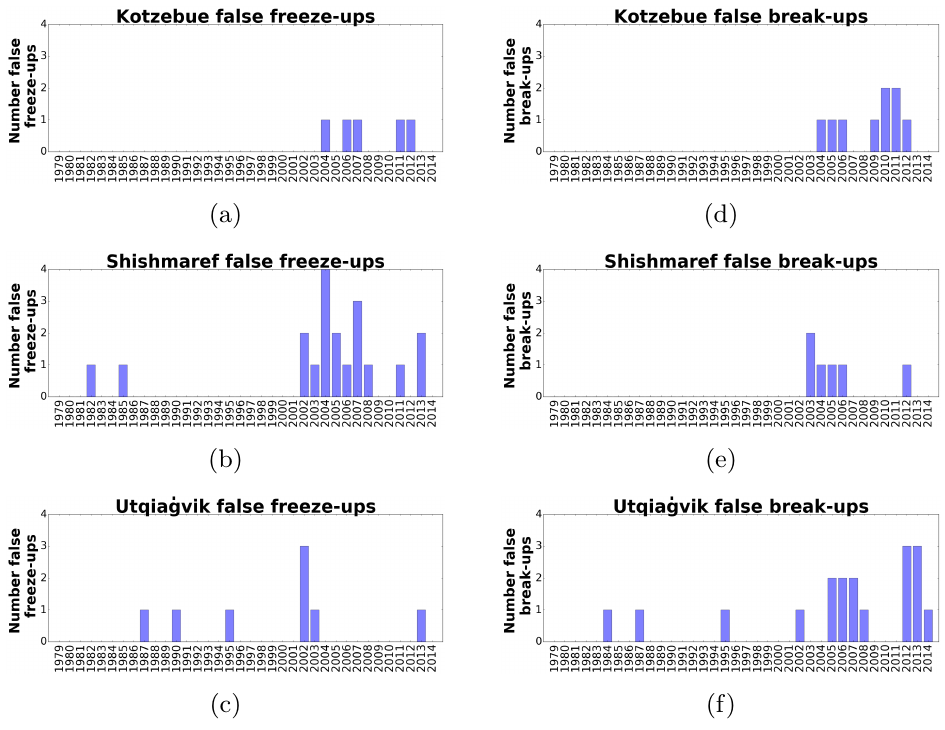
Figure 5. The number of false freeze-ups (a–c) and break-ups (d–f) per year, identified from ERA-I daily sea ice concentration data. False freeze-ups (break-ups) are defined as the number of times the ice concentration oscillated above and below the sea ice concentration threshold value of 15% before the last freeze-up (break-ups) was finally achieved.